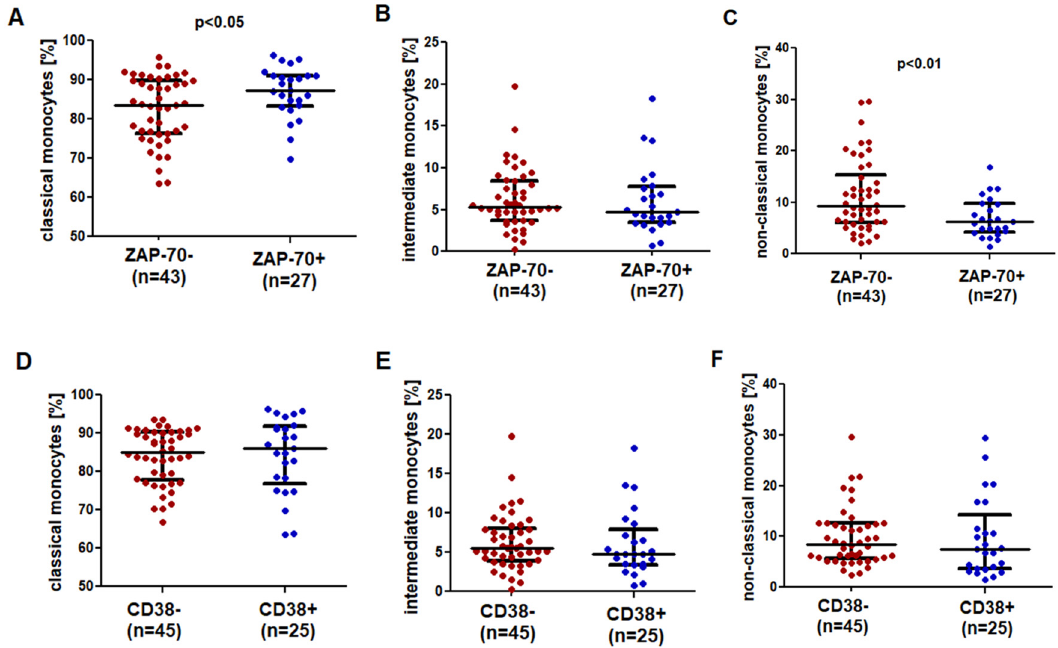
Figure 4. Comparison of the percentage of ( A , D ) classical, ( B , E ) intermediate and ( C , F ) non-classical monocytes in CLL patients ZAP-70-positive and ZAP-70-negative and CD38-positive and CD38- negative group. The solid line marks the median value. Ɪ represents the interquartile range (IQR). The percentages of classical, intermediate and non-classical monocytes were compared between the groups of patients with and without the negative cytogenetic aberrations del(11q22.3) and/or del(17p13.1). No significant differences between those groups were noted (Figure 5A–C).